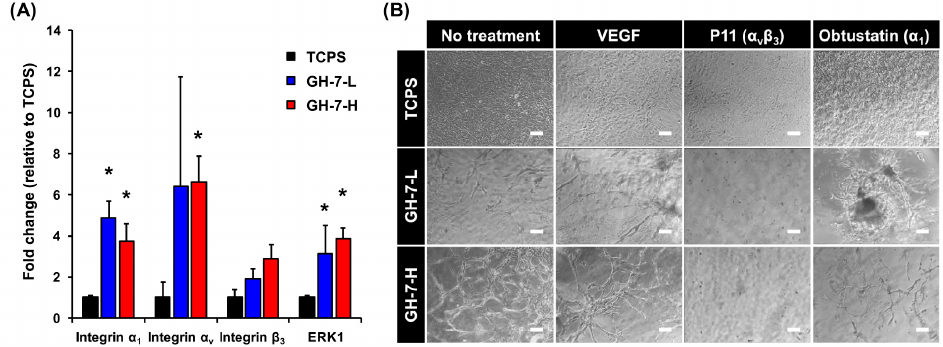
Figure 2. Integrin-mediated mechanisms at the cell–material interface. mRNA expression levels of mMSCs cultured for 15 days either on tissue culture polystyrene (TCPS) (control) or embedded in GH-7-L and GH-7-H hydrogels, * p < 0.05 vs. TCPS ( n = 3) ( A ); Integrin inhibition effects on connectivity of blood vessels formed when mMSCs were cultured in GH-7-L and GH-7-H hydrogels. The experiment groups include mMSCs cultured on TCPS, GH-7-L, and GH-7-H gels for 15 days with no treatment, soluble vascular endothelial growth factor (VEGF), P11 (integrin α v β 3 inhibitor), and obtustatin (integrin α 1 inhibitor). Scale bars indicate 200 µm ( B ).